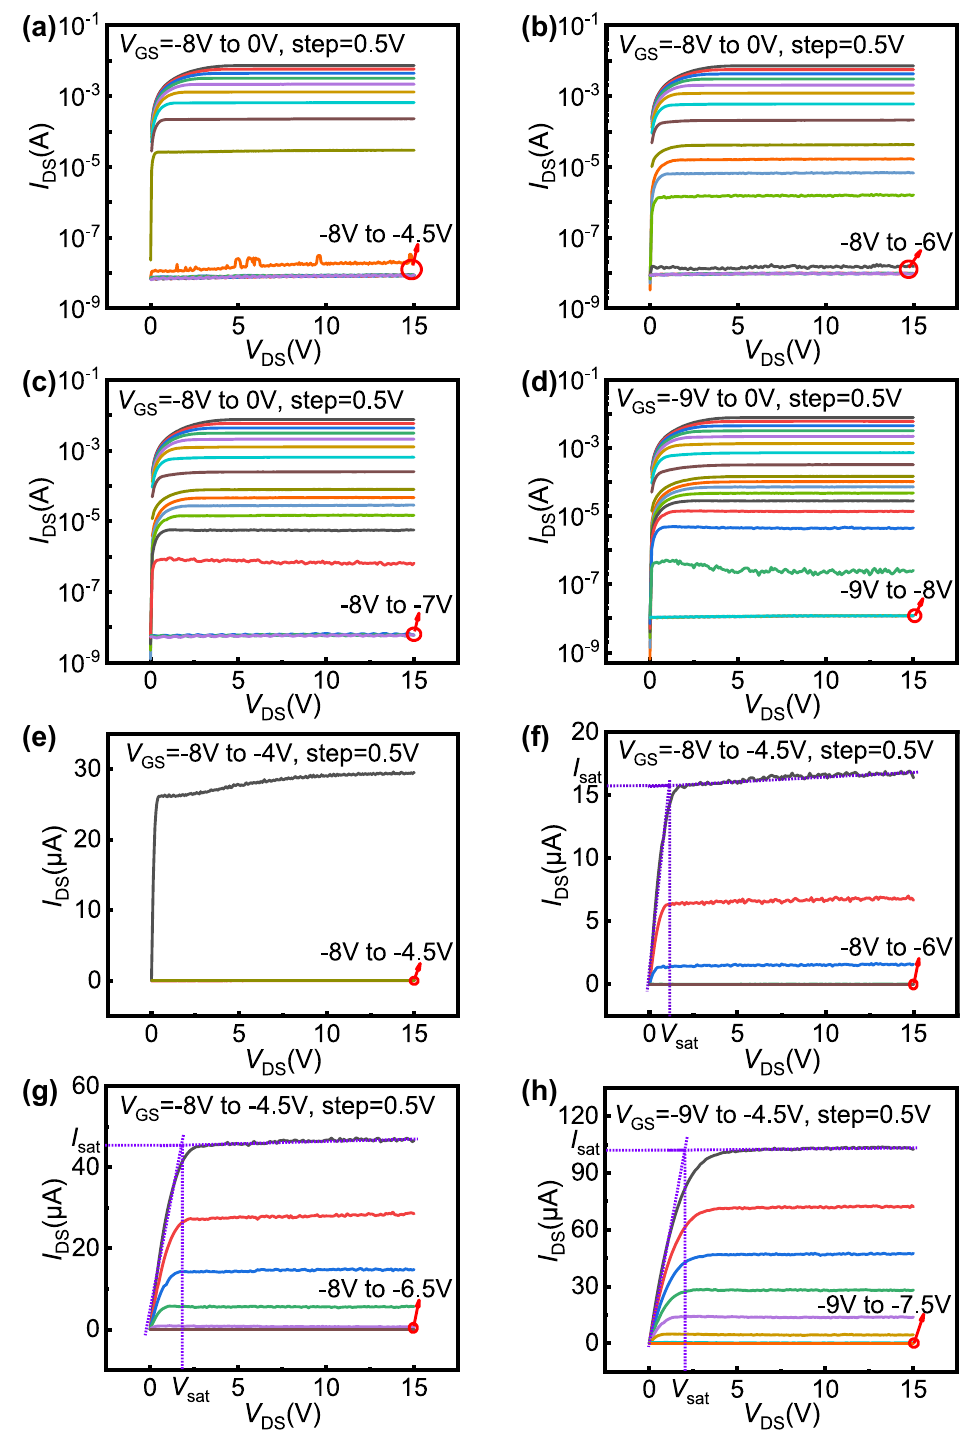
Figure 2. The measured output characteristics with logarithmic y-axis: ( a ) sample 1, ( b ) sample 2, ( c ) sample 3, and ( d ) sample 4. The measured output characteristics with standard y-axis at a specific range of gate bias: ( e ) sample 1, ( f ) sample 2, ( g ) sample 3, and ( h ) sample